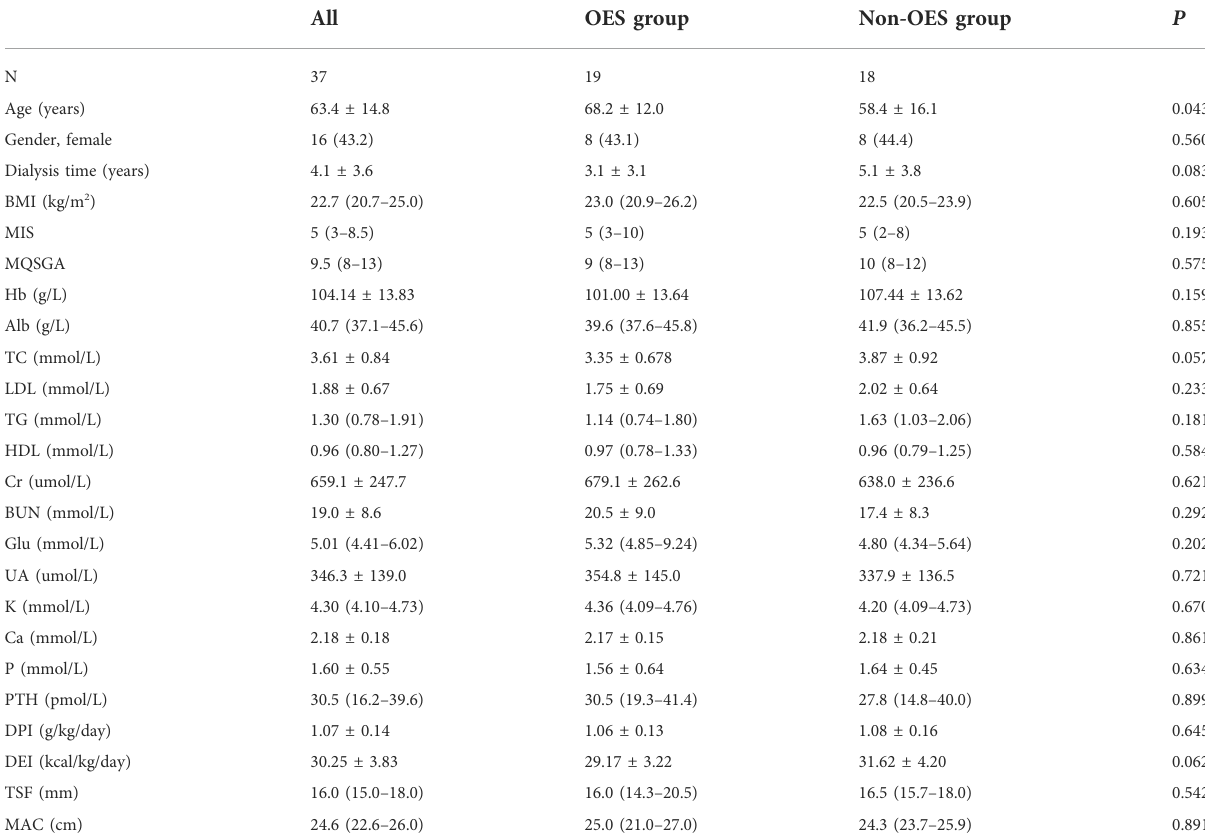
TABLE 1 Demographic, anthropometric, and nutritional characteristics of the study population. All OES